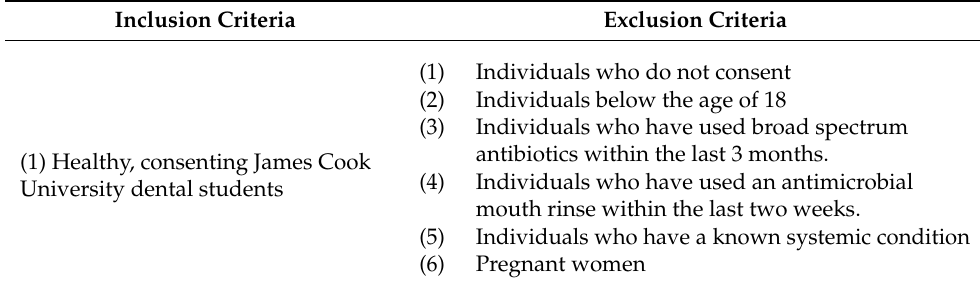
Table 1. Criteria for volunteers for plaque